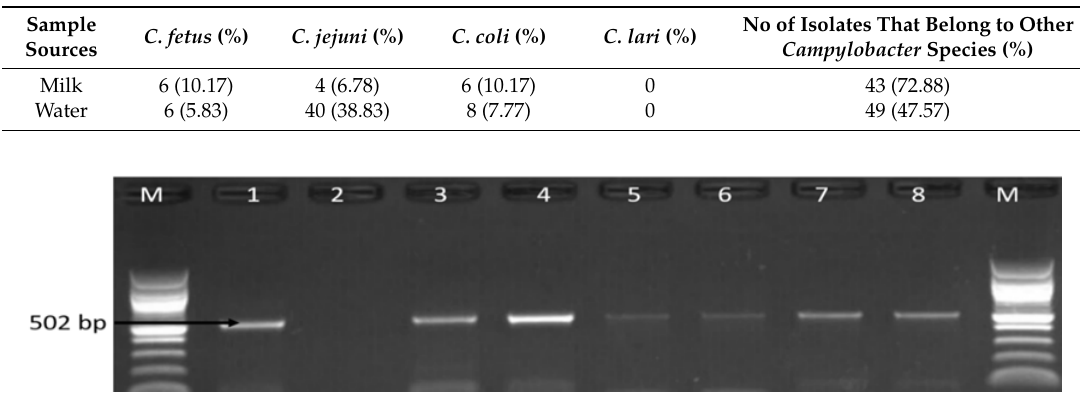
Table 1. Distribution patterns of Campylobacter species identified in the sample sources.